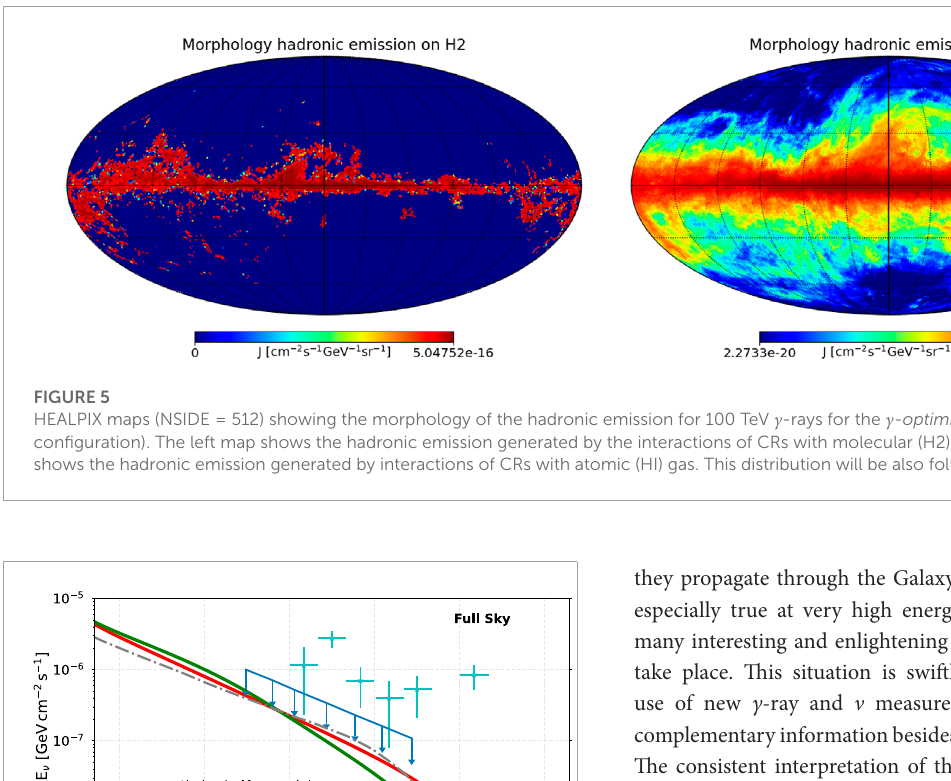
FIGURE 6 Full sky ν diffuse emission predicted from the γ - optimized model (Min and Max configurations) compared to the model-independent upper limits obtained from the ANTARES collaboration. The predicted galactic ν flux from the KRA γ model (cutoff energy of E c = 5 PeV) (Gaggero et al., 2015a) is also included. In addition, the IceCube astrophysical ν flux as measured from IceCube using 7.5 years of track events (Abbasi et al., 2021) are added for